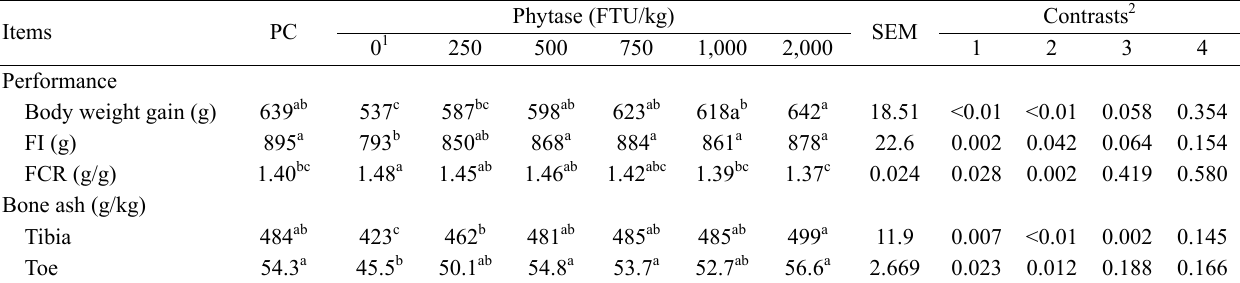
Table 3. Influence of phytase dose on 21-d body weight gain, feed intake (FI), feed conversion ratio (FCR) and bone ash content of broiler chickens fed corn/soybean diets